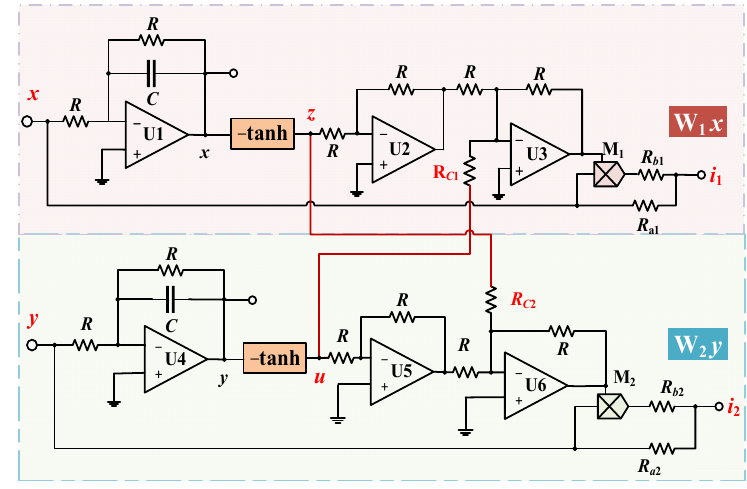
Figure 4. Hyperbolic-type memristor emulator with crosstalk.